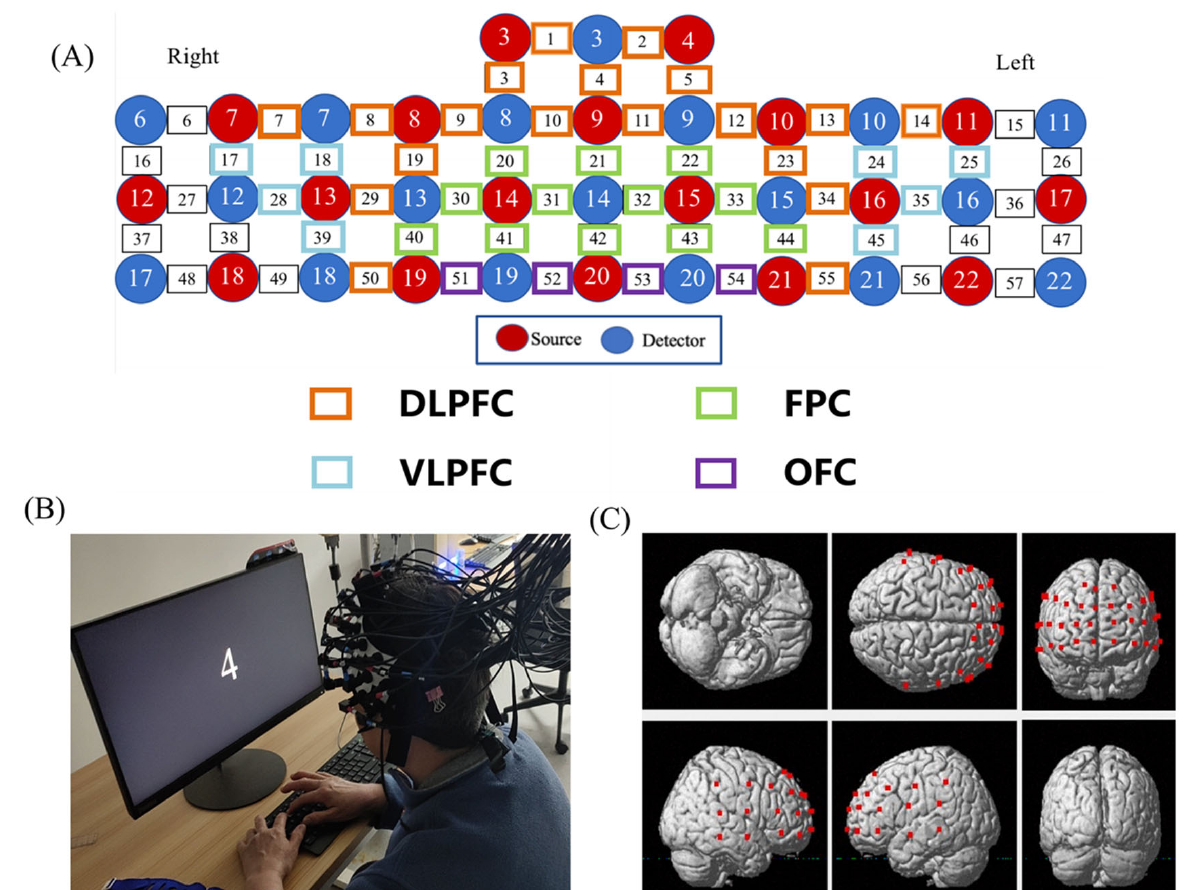
Figure 2. The map of fNIRS channels. ( A ) The distribution of PFC channels and brain regions according to the 3D digitizer. ( B ) Subjects performing the N-back test. ( C ) Channels layout in the PFC. (DLPFC, dorsolateral prefrontal cortex; FPC, frontopolar cortex; VLPFC, Ventrolateral prefrontal cortex; OFC, orbital frontal cortex.).